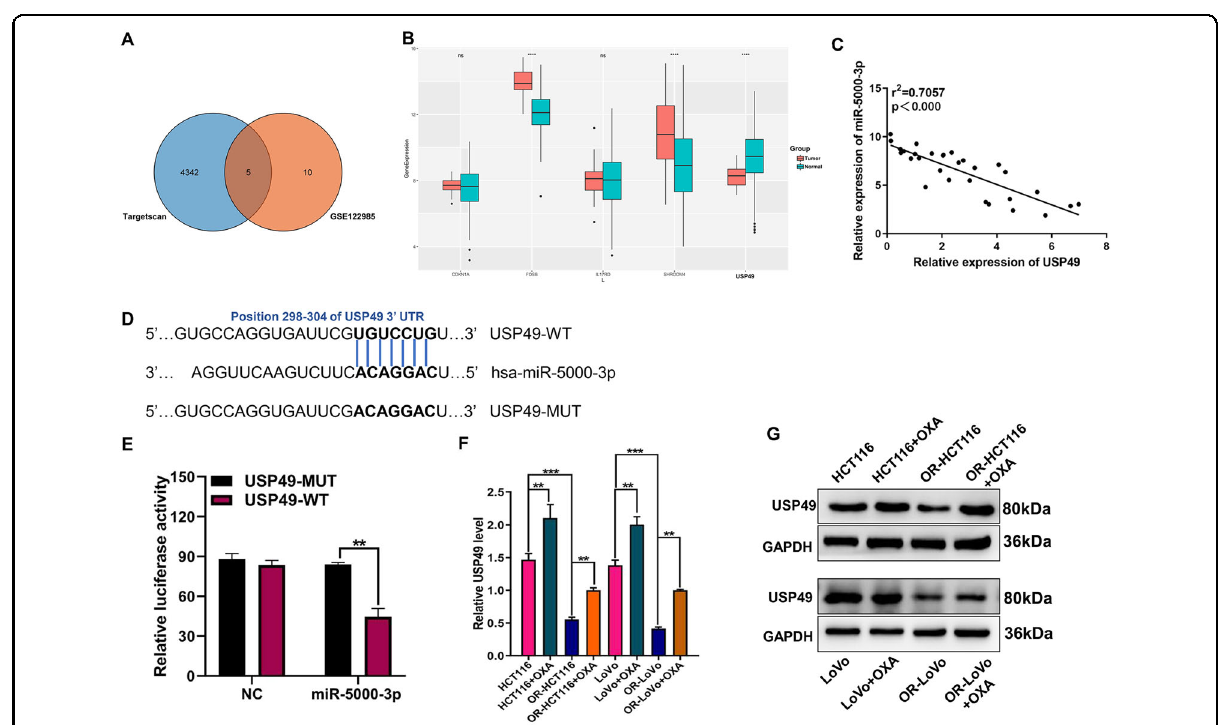
Fig. 5 miR-5000-3p regulates USP49 mRNA and protein expression by targeting the 3 ′ UTR in OR-CRC cells. A We combined the TargetScanHuman 7.2 databases predicting the putative targets of miR-5000-3p and GEO dataset screening DEGs between CRC cells and OR-CRC cells, and there were fi ve predicted targets that overlapped among the two online databases. Venn diagrams showing the fi ve DEGs ( p < 0.05 & | logFC|>1). FC, fold change. B The expression levels of CDKN1A, SHROOM4, FOSB, USP49, and IL17RD in normal or CRC tissues from Colon Adenocarcinoma (COAD) were analyzed by starBase online, which was based on the TCGA database (http://starbase.sysu.edu.cn). C The scatter plots showing correlation between expression of miR-5000-3p and USP49 in COAD. r 2 = 0.7057 and p < 0.000. D , E Luciferase activity assays of the activity of luciferase vectors containing the USP49 3 ′ UTR were performed following transfection with miR-5000-3p or negative control (NC) for 24 h using the Dual-Luciferase Reporter Assay System. F , G The mRNA and protein expression levels of USP49 in two CRC cell lines (HCT116 and LoVo) or their oxaliplatin (OXA)-resistant cell lines (OR-HCT116 and OR-LoVo) or after OXA treatment from qRT-PCR assay ( F ) and western blot ( G ). * p < 0.05, ** p < 0.01, and *** p <